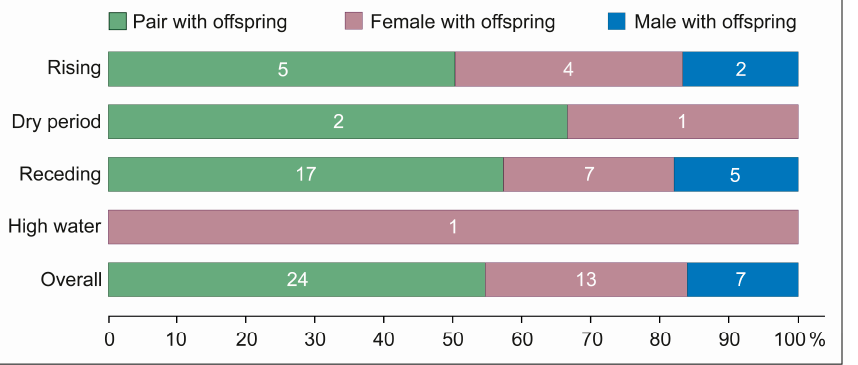
Figure 3. Number of independent captures (based on a 30 min independence interval) of Bare-faced Curassow ( Crax fasciolata ) adult(s) with offspring grouped by female, male, and pair (male–female) for the overall study and for seasonal period defined by water regime (high water, receding, dry period, and rising) obtained between July 2015 and December 2017 in the Northern Pantanal (Mato Grosso, Brazil).